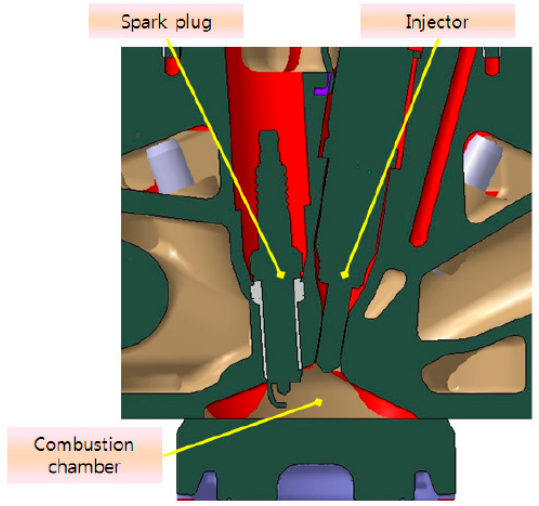
Figure 1. Schematic of a combustion chamber with the location of the spark plug and fuel injector.